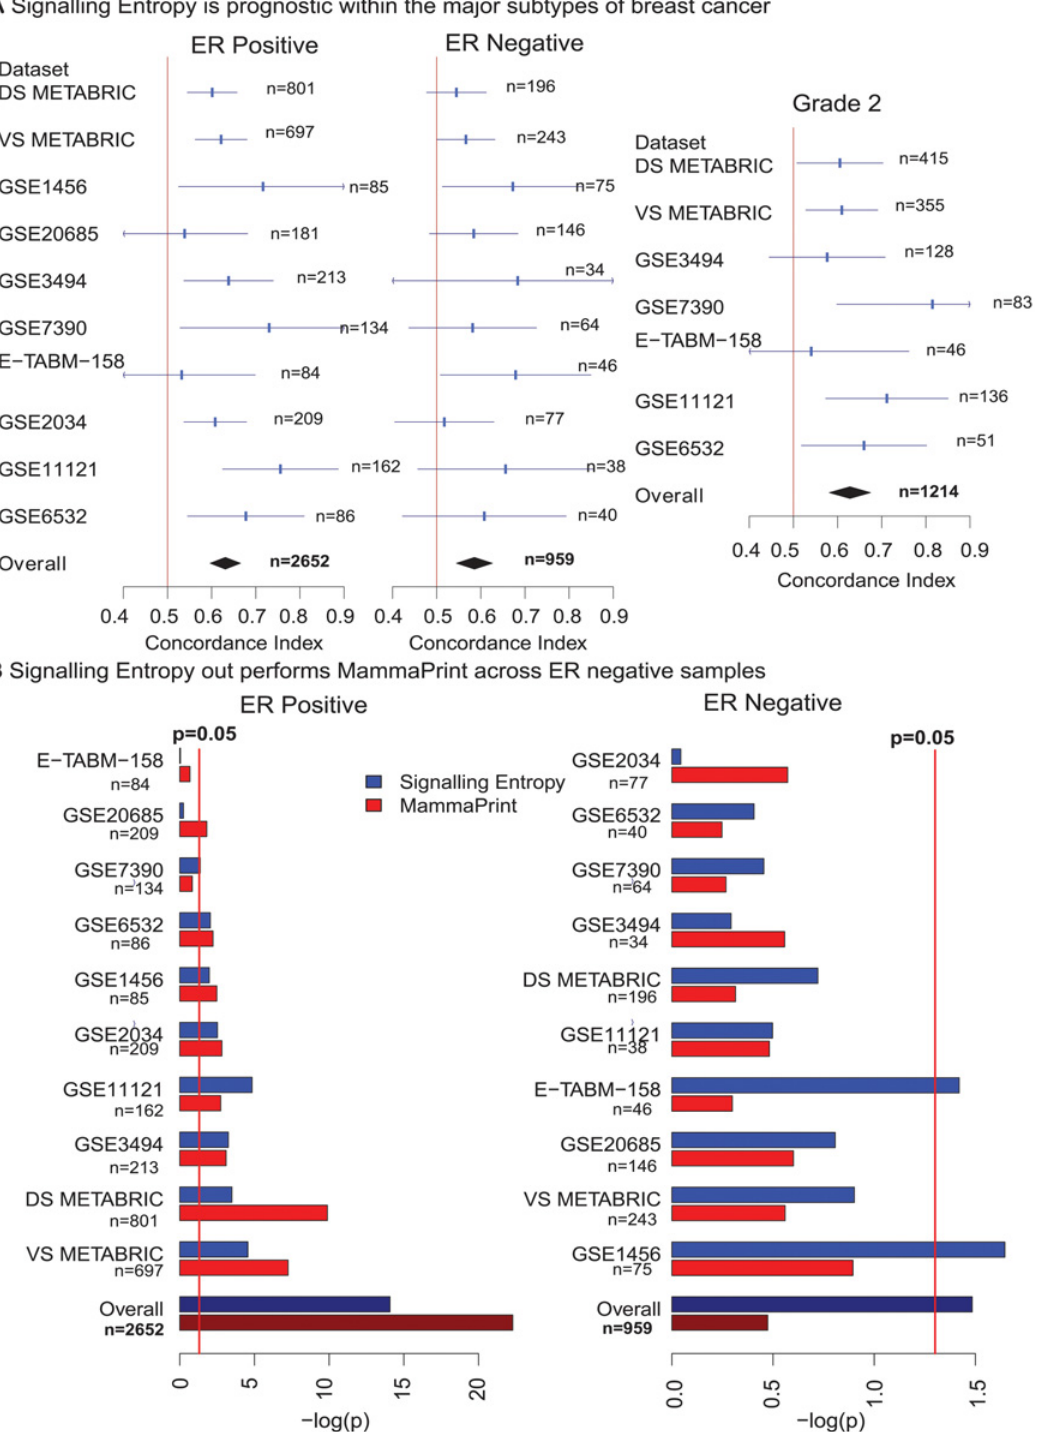
Fig 2. Prognostic implications of signalling entropy in breast cancer. A) The plots display the concordance index for signalling entropy in each data set alongside its 95% confidence interval. The overall concordance index was derived via meta-analysis using a random effects model. The vertical line denotes concordance index = 0.5, data sets where the confidence interval for the concordance index crosses this line did not reach significance. Meta- analysis of signalling entropy across 10 breast cancer data sets reveals that our measure is significantly prognostic across both ER positive and ER negative subtypes. Meta-analysis across 7 breast cancer data sets reveals that our measure is also significantly prognostic within the grade 2 stratum. B) The plots